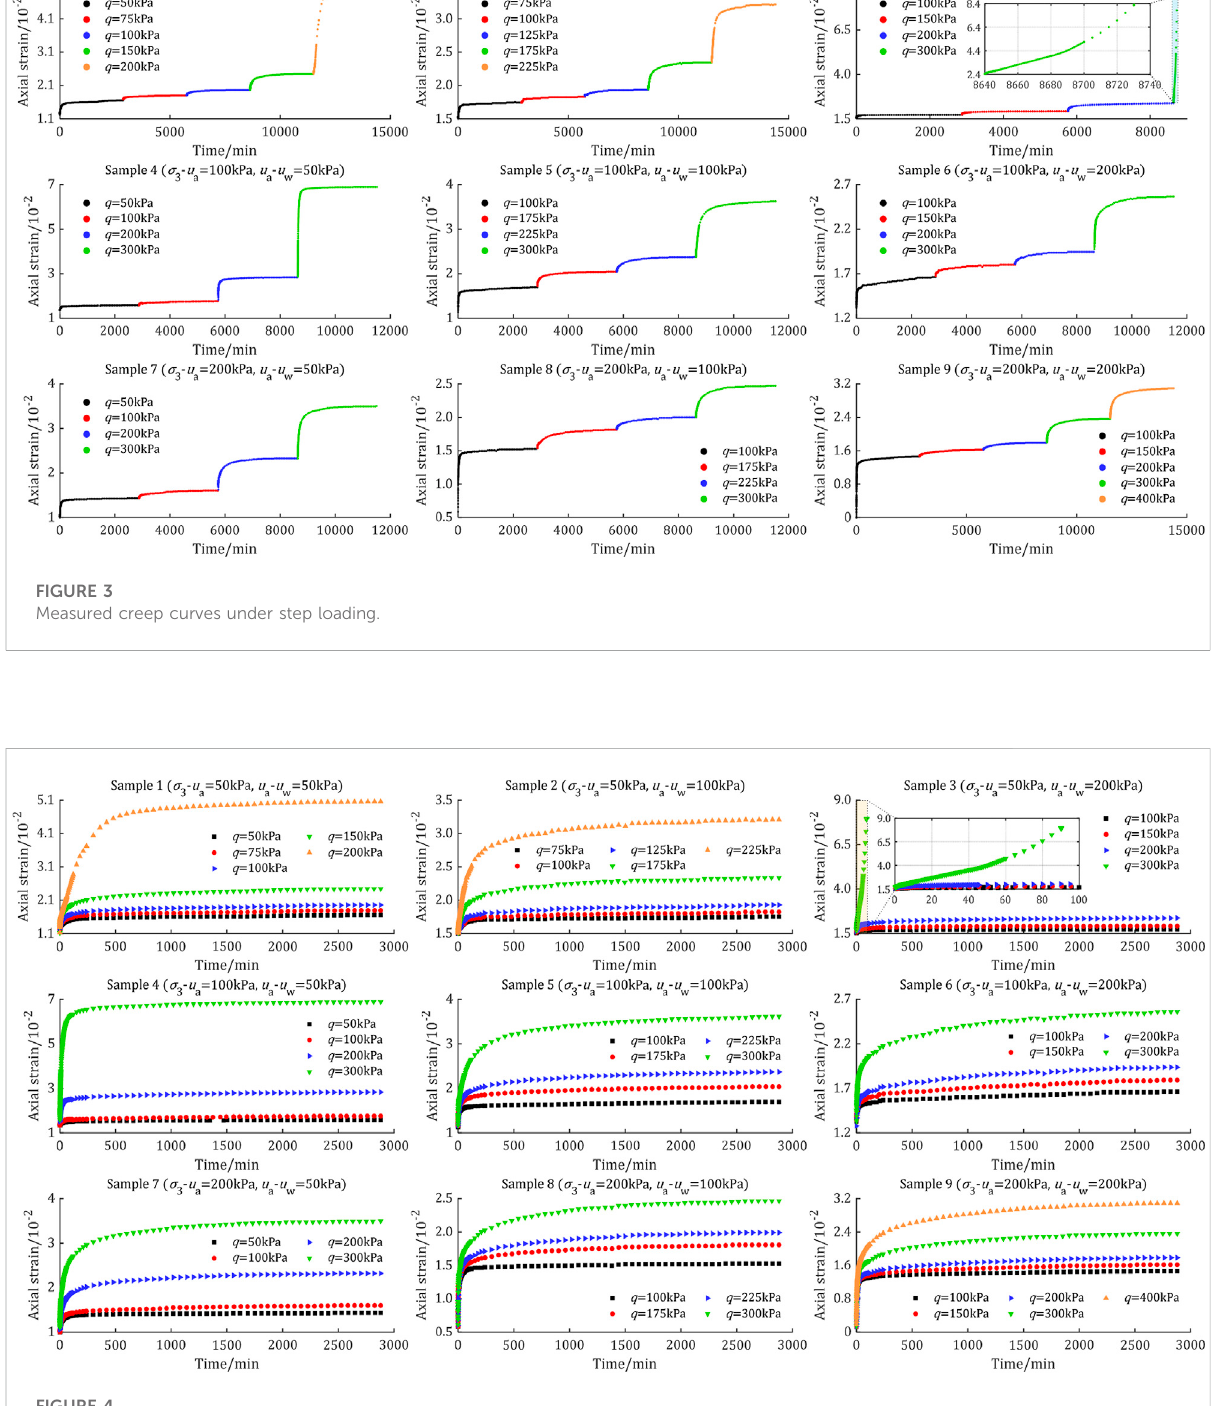
FIGURE 4 Creep curve cluster under different stress